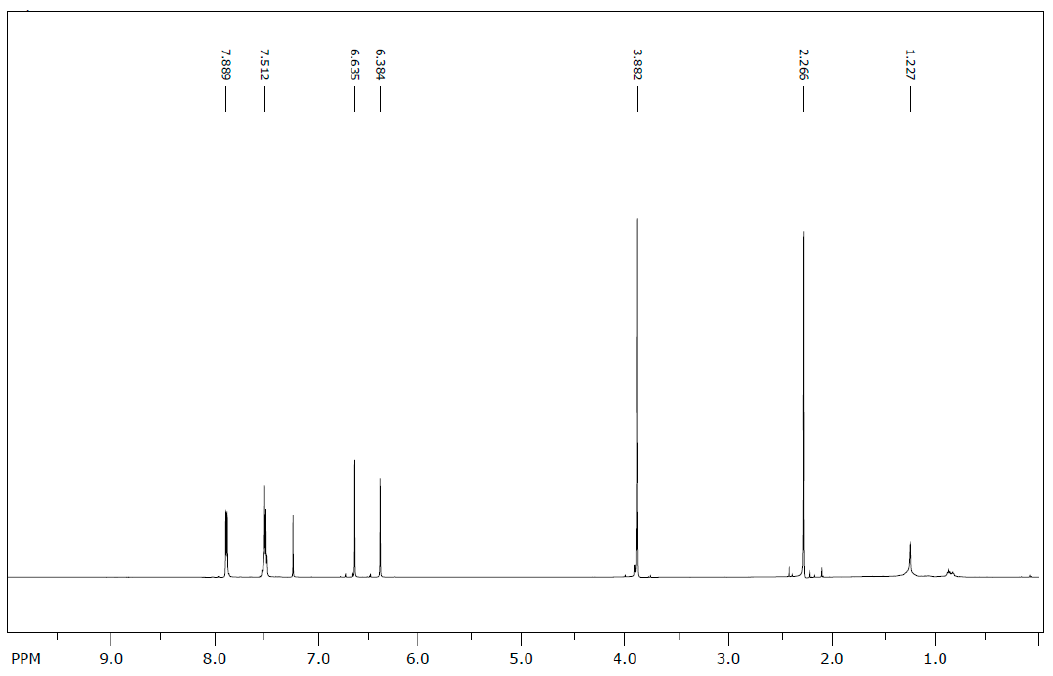
Figure 2. 1 H-NMR spectrum of 6-methyltectochrysin.